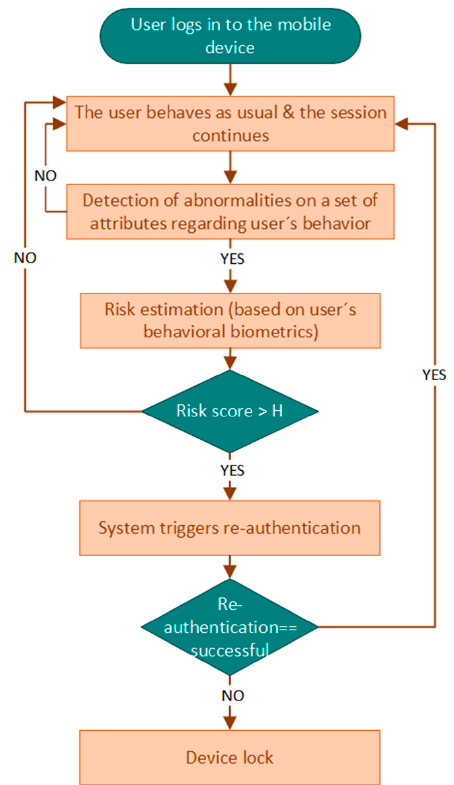
Figure 1 . An overview of risk-based continuous user authentication relying on behavioral biometrics.